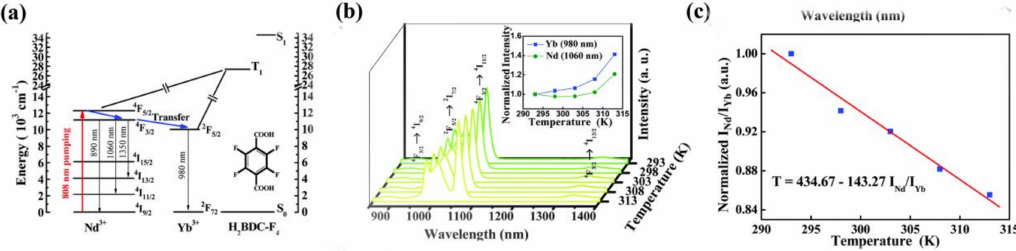
Figure 12. ( a ) Schematic representation of energy processes in Nd 0.577 Yb 0.423 BDC-F 4 . ( b ) Emission spectra of Nd 0.577 Yb 0.423 BDC-F 4 in the range of 293–313 K excited at 808 nm; inset: temperature dependence of the normalized intensity of the corresponding transitions. ( c ) Temperature-dependent intensity ratio of Nd 3+ (1060 nm) to Yb 3+ (980 nm) and the fitted curve for Nd 0.577 Yb 0.423 BDC-F 4 . Reproduced with permission from [123]. Copyright 2015 The Royal Society of